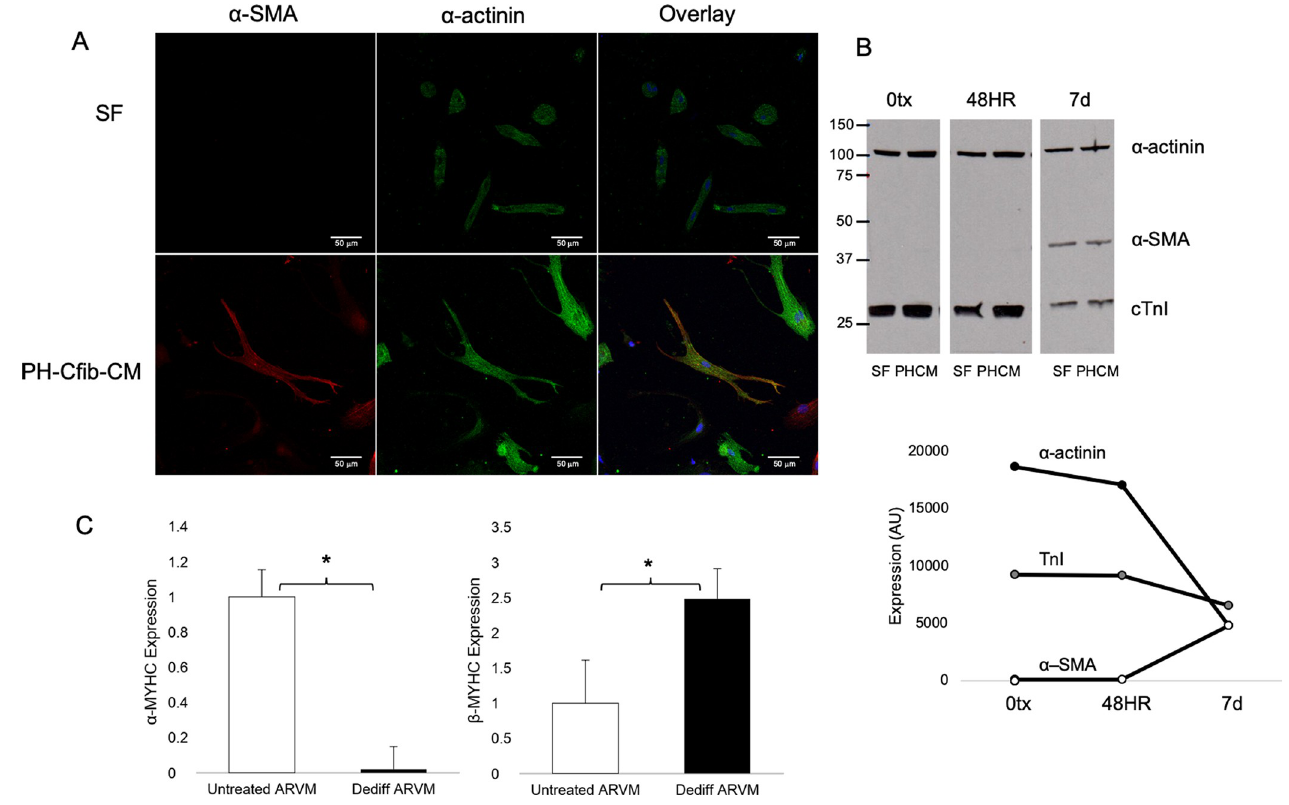
Fig 3. Dedifferentiated adult myocytes retain expression of cardiac markers. A) Immunofluorescent staining of dedifferentiated myocytes after 7 days SF or PH-CM exposure. Dedifferentiated cells still express α -actinin (green), while also starting to express α -SMA (red). Cells in SF media are less viable by 7 days, and do not dedifferentiate. Images were taken on a Zeiss Laser Scanning Microscope 780 at 40x objective. B) Protein expression of sarcomeric α -actinin, cardiac troponin I (cTnI) and α -SMA in myocytes exposed to SF media or PH-CM for 48 hours or 7 days. CD) Dedifferentiated myocytes activate the fetal gene program. By 7 days in culture, cells exposed to PH-CM demonstrate downregulated SERCA and α -MYHC expression. Expression of the fetal gene program was assessed by qRT-PCR using validated primers. Data are expressed as Δ Ct to allow comparison across all groups. Higher reflects lower expression. n = 2 at each time-point. � p < 0.05 compared to